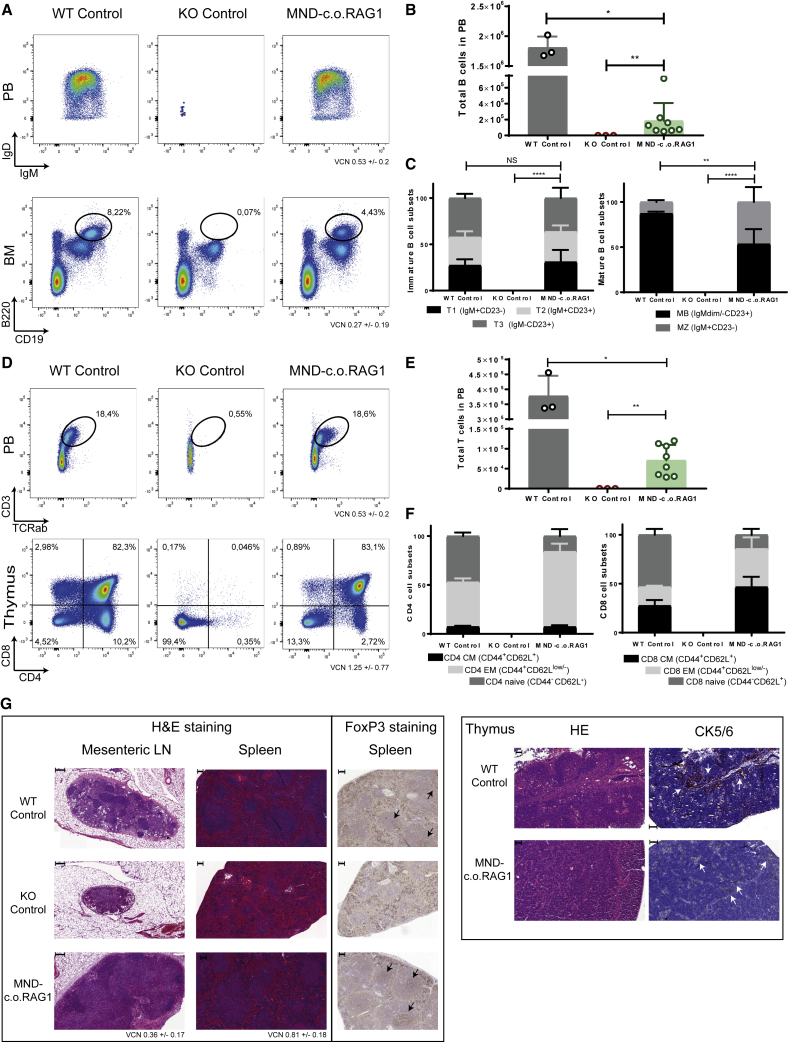
Extensive Immune Reconstitution of Mice Receiving Gene Therapy of Stem Cells with a Clinical-Grade MND-c.o.RAG1 VectorRag1-deficient mice were transplanted with 250,000 stem cells: WT cells (three mice), mock KO cells (three mice), and MND-c.o.RAG1-treated cells (VCN of 0.2; eight mice). (A) Representative plots of B cell reconstitution in the blood (B220+IgM/IgD cells; top panel) and B cell development in the BM (B220+CD19+ cells; bottom panel) 24 weeks after transplantation. (B) Total number of B cells (B220+CD11b/CD43− cells) in the PB (Mann-Whitney test, one-tailed; ∗p < 0.05, ∗∗p < 0.01). (C) Immature (B220+CD93+ cells; left panel) and mature (B220+CD93- cells; right panel) B cell subsets distribution in spleen. Two-way ANOVA test; ∗∗∗p < 0.001; ∗∗∗∗p < 0.0001. (D) Representative plots of T cell reconstitution in the blood (CD3+TCRab+ cells; top panel) and T cell development in the thymus (CD4 versus CD8 cells; bottom panel) 24 weeks after transplantation. (E) Total number of T cells (CD3+TCRab+ cells) in PB at the end of the experiment (24 weeks) (Mann-Whitney test, one-tailed; ∗p < 0.05, ∗∗p < 0.01). (F) Naive, effector memory (EM), and central memory (CM) subset distributions for CD4 (CD3+TCRab+CD4+; left panel) and CD8 (CD3+TCRab+CD8+; right panel). T cell subset distributions in spleen are shown: naive cells (CD44−CD62L+), EM cells (CD44+CD62L−) and CM cells (CD44+CD62L+) 24 weeks after transplantation. (G) Left panel: Hematoxylin and eosin staining of mesenteric lymph nodes (scale bars, 200 μm) and spleen (scale bars, 100 μm; purple indicates germinal centers, and red indicates red pulp). Representative FoxP3 staining in spleen tissue (scale bars, 100 μm) is shown. Arrows indicate positive FoxP3 in germinal centers. Representative images are from WT control, KO control, and MND-c.o.RAG1 gene therapy mice. Right panel: Histological analysis of thymus reconstitution by hematoxylin and eosin staining (scale bars, 50 μm) and cytokeratin 5/6 staining (scale bars, 100 μm) . Representative images from WT control and MND-c.o.RAG1 mice. KO thymus was completely used for phenotyping (FACS, DNA, RNA), but KO thymic histology was previously described by van Til et al.27